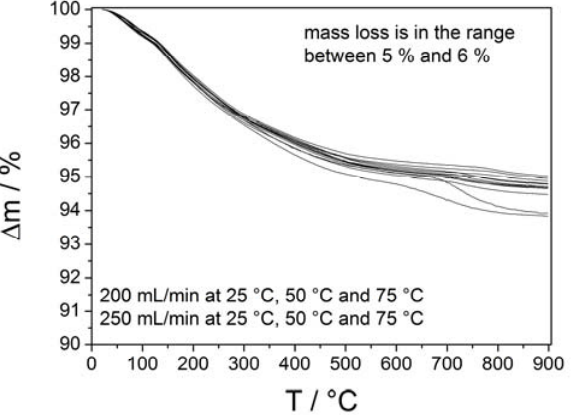
Figure 2. Thermogravimetric analysis of the final products. The samples show a mass loss of between 5 and